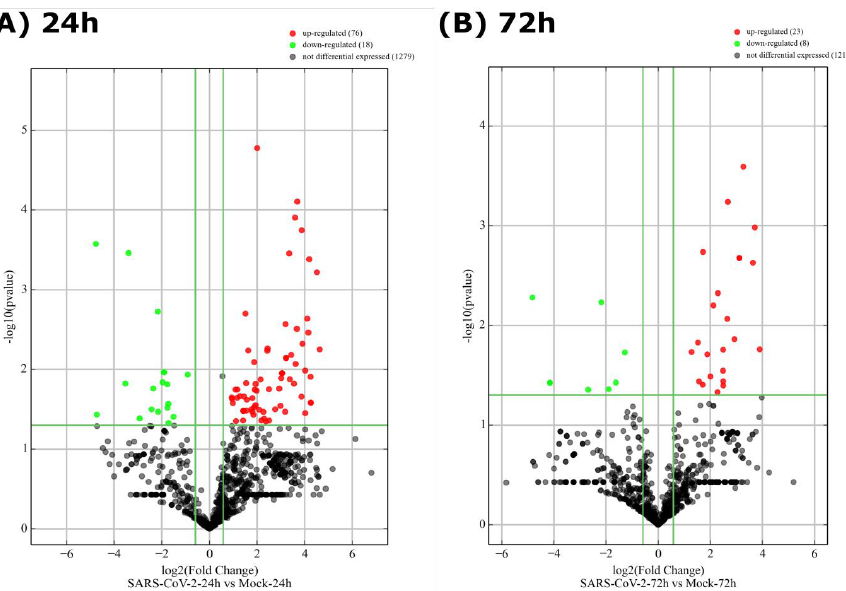
Figure 4. Volcano plot of differentially expressed miRNAs. Plots depicting the magnitude (log 2 reporting fold change, FC, x-axis) and significance (−log 10 adjusted p value, y-axis) of differentially expressed miRNAs between Mock and SARS-CoV-2-infected Calu-3 cells ( A ) 24 h and ( B ) 72 h post- infection. The green, red and black spots represent upregulated, downregulated and non-differen- tially expressed miRNAs, respectively. The statistical significance threshold ( p ≤ 0.05) is illustrated by the horizontal green line and the threshold of fold change (log 2 FC > 1 or <−1) by the two vertical green lines. The heat map listing differentially expressed miRNAs from three independent sam- ples (three infected, three uninfected controls) at 24 h and 72 h particularly highlights two miRNAs that are upregulated upon SARS-CoV-2 infection: miR-1246 and miR-1290 (Fig- ure 5). Tables 1 and 2 summarize the fold change along with the p -value and false discov- ery rate (FDR) of the top 10 up- and down-regulated miRNAs after infection at 24 h and